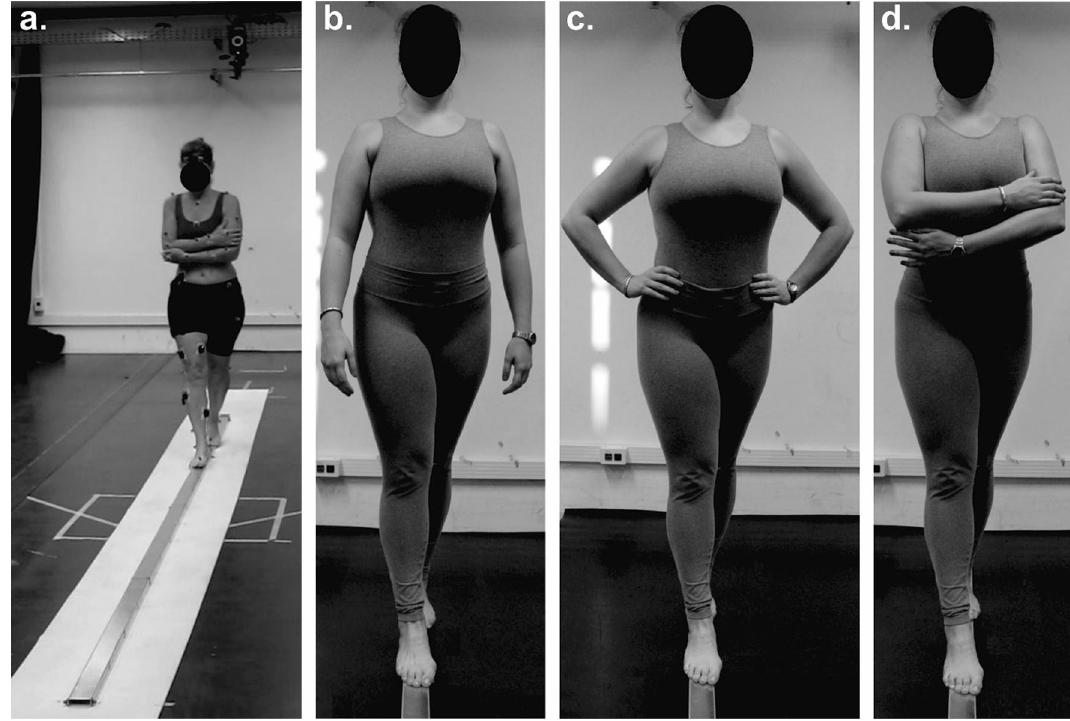
Figure 5. Representation of the experimental setup ( a ) and the three arm positions: free arms ( b ), akimbo ( c ), and crossed arms ( d